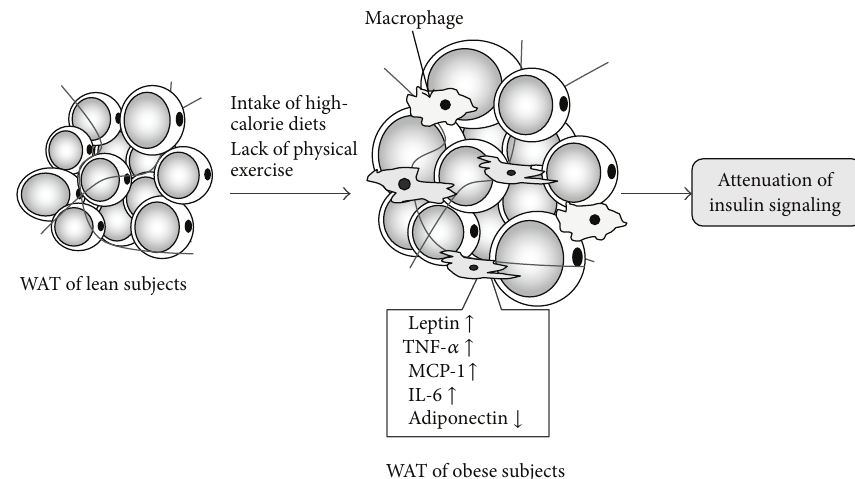
Figure 2: Model of the development of chronic inflammation in WAT. Adipocytes begin to grow as a result of factors such as excess energy intake and lack of exercise, and MCP-1 is secreted from these enlarged adipocytes. Macrophages infiltrate into WAT by the action of MCP-1, and as a result, increased expression of inflammatory adipokines (TNF- 𝛼 , MCP-1, and IL-6) and decreased expression of anti- inflammatory adipokines (adiponectin) occur in WAT. Dysregulated expression of adipokines-induced inflammation of WAT contributes to the development of insulin